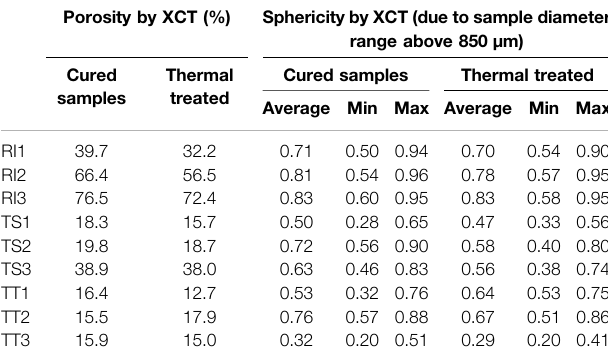
TABLE 5 | Porosity by XCT of the investigated alkali-activated foams cured at 70 ° C and thermally treated at 1,000 ° C. Porosity by XCT (%) Cured